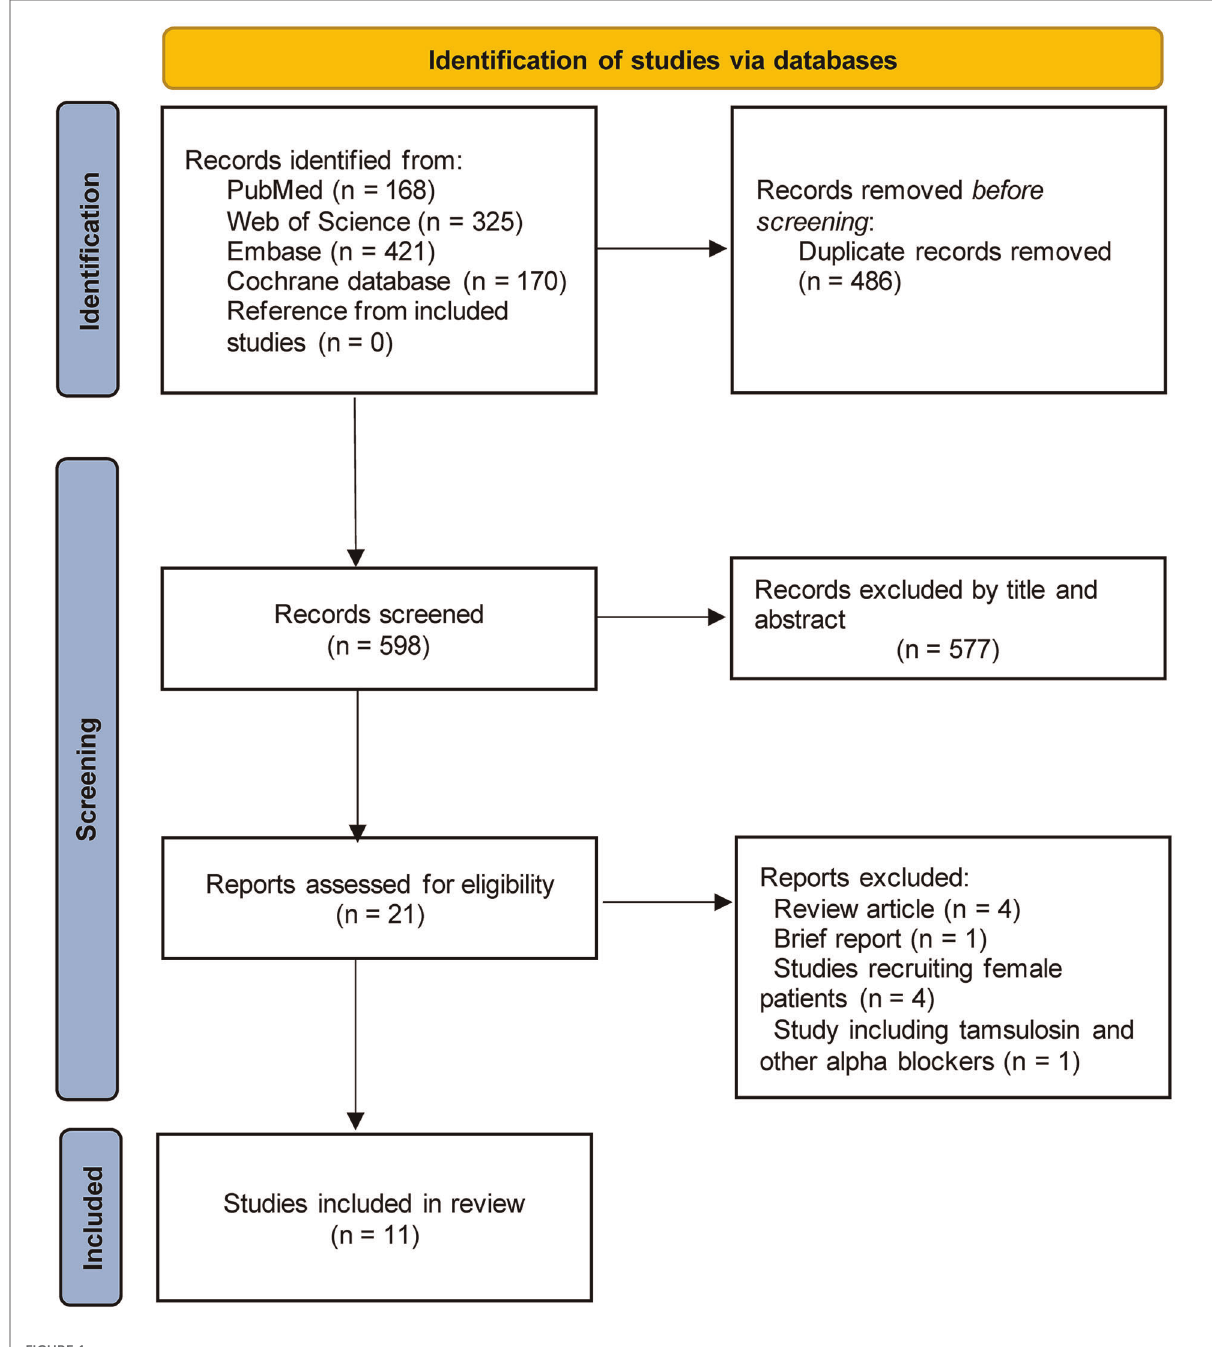
FIGURE 1 Flowchart of